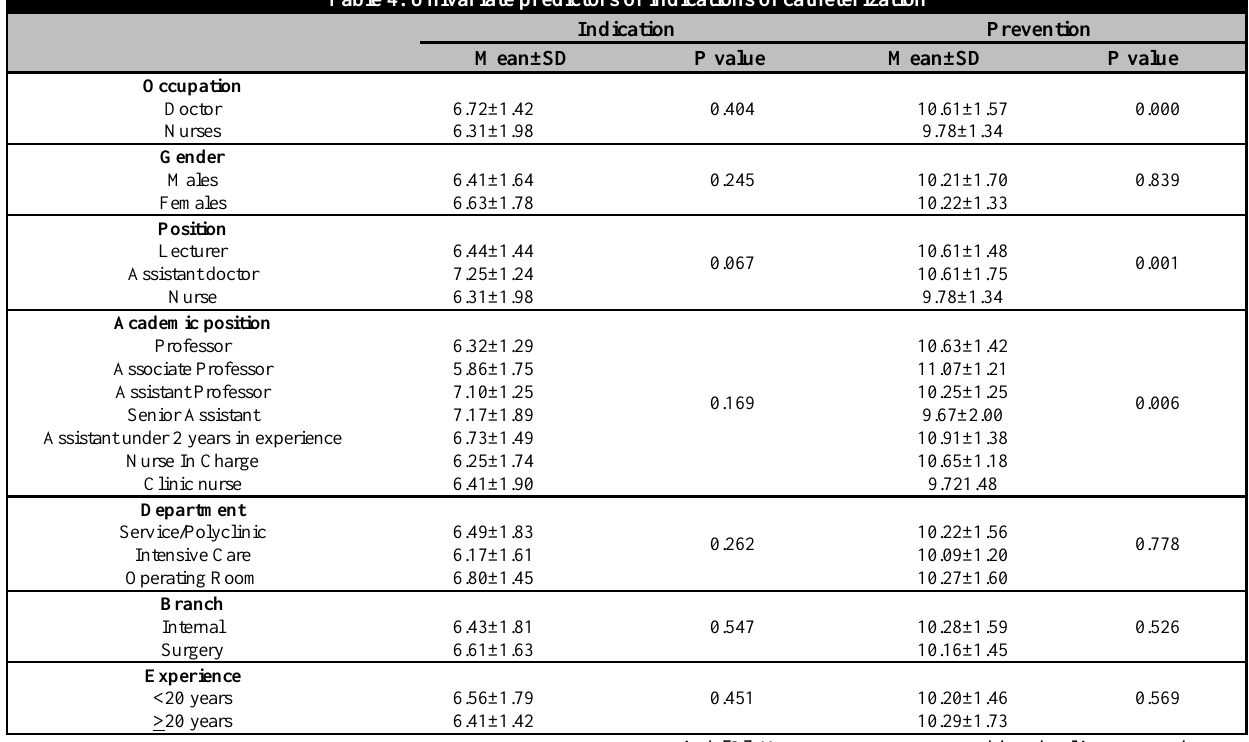
Table 4: Univariate predictors of indications of catheterization Indication